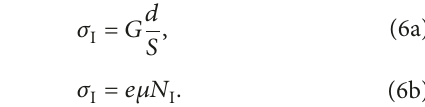
Figure 7: Temperature dependencies of the ion conductivity 𝜎 ion mobility 𝜇 in the YSZ